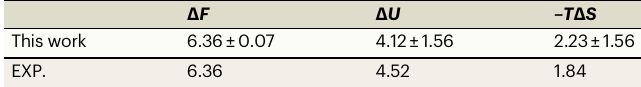
Table 1 | Our simulation estimates of the free energy, enthalpy, and entropy of binding at T = 300 K and corre- sponding experimental data 55,56 Δ